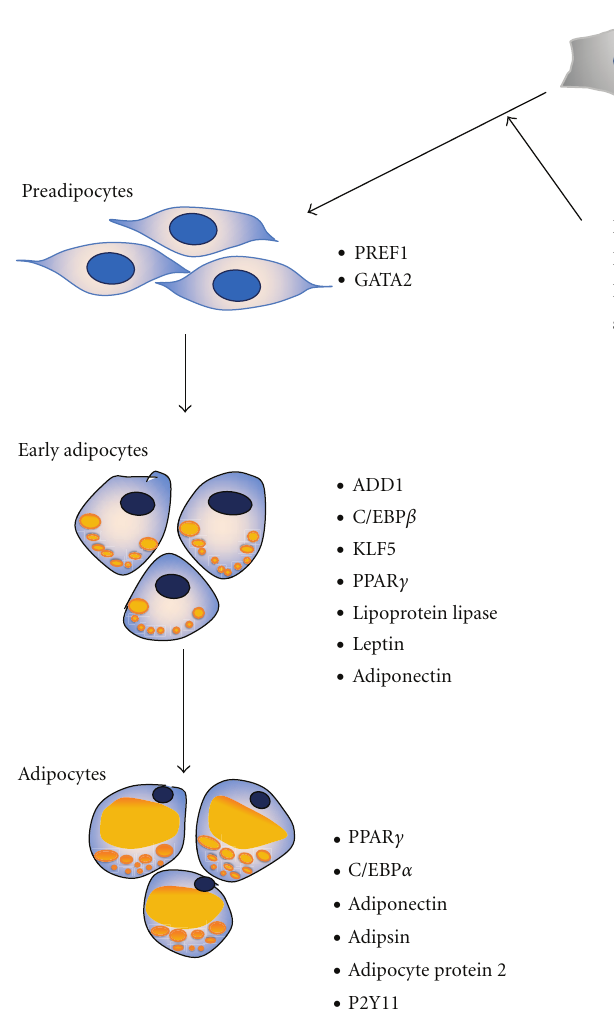
Figure 3: Di ff erentiation of mesenchymal stem cells towards adipocytes. Peroxisome proliferator-activated receptor gamma (PPAR γ ) commits MSCs towards adipogenic lineage. Preadipocyte factor 1 (Pref-1) and GATA binding protein 2 (Gata2) are expressed in preadipocyte. In early adipocyte determination and di ff erentiation factor (ADD1), CCAAT/enhancer binding protein beta (C/EBP β ), Kruppel-like factor 5 (KLF5), PPAR γ , lipoprotein lipase (LPL), leptin and adiponectin are expressed. The early adipocyte develops